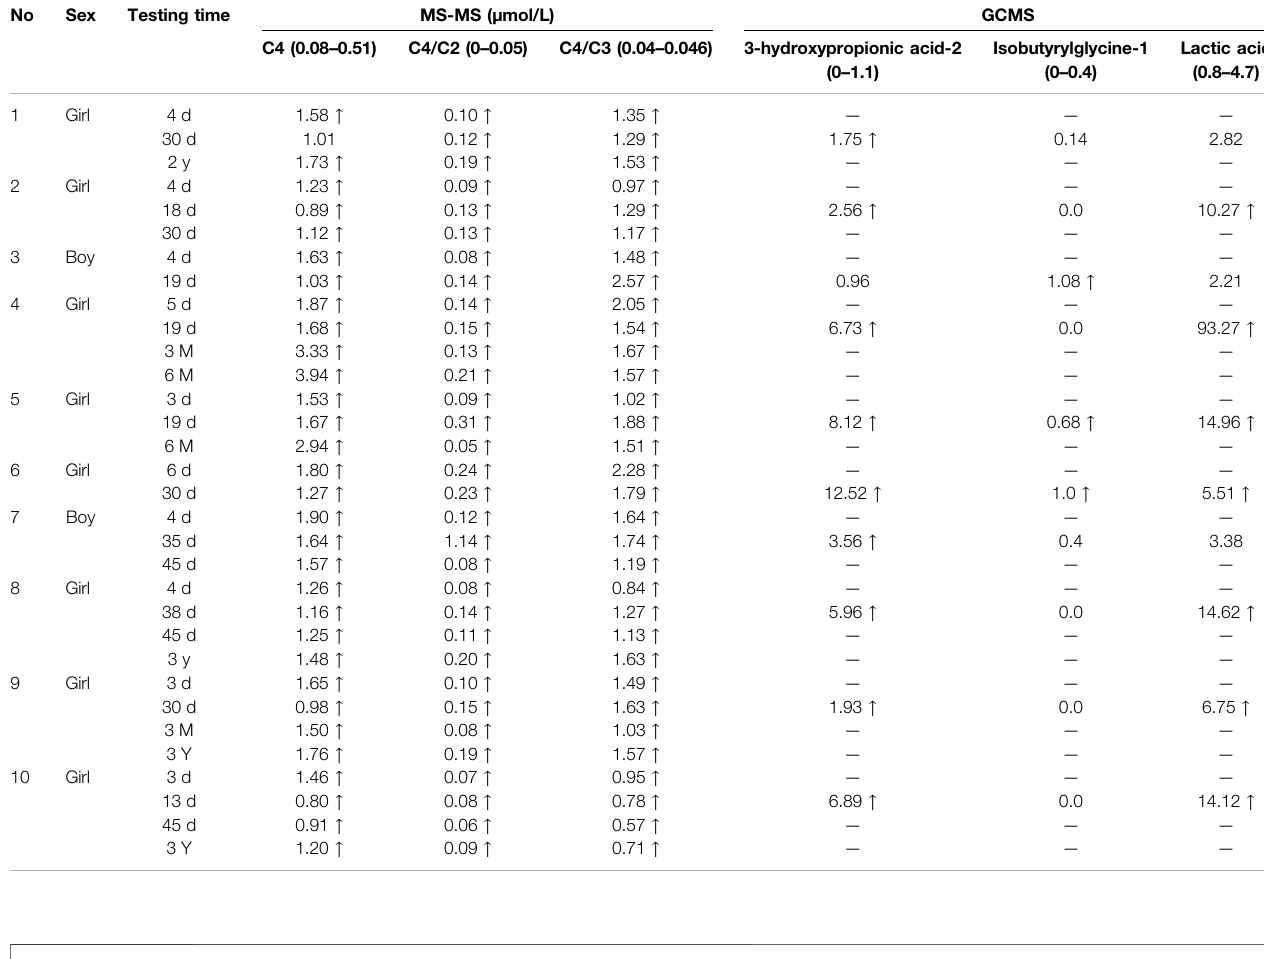
TABLE 1 | Results of tandem mass spectrometry (MS/MS) and urine GCMS analysis of 10 cases of IBDHD.